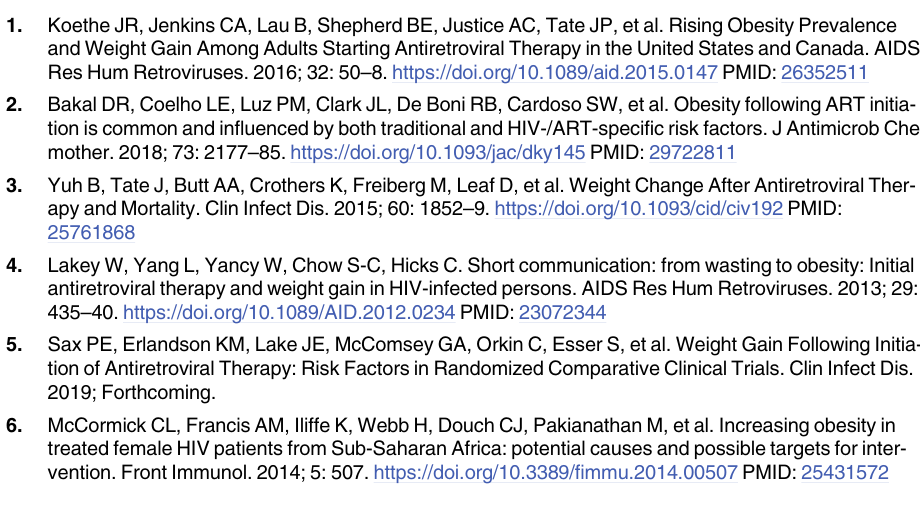
value in the MC4R 50